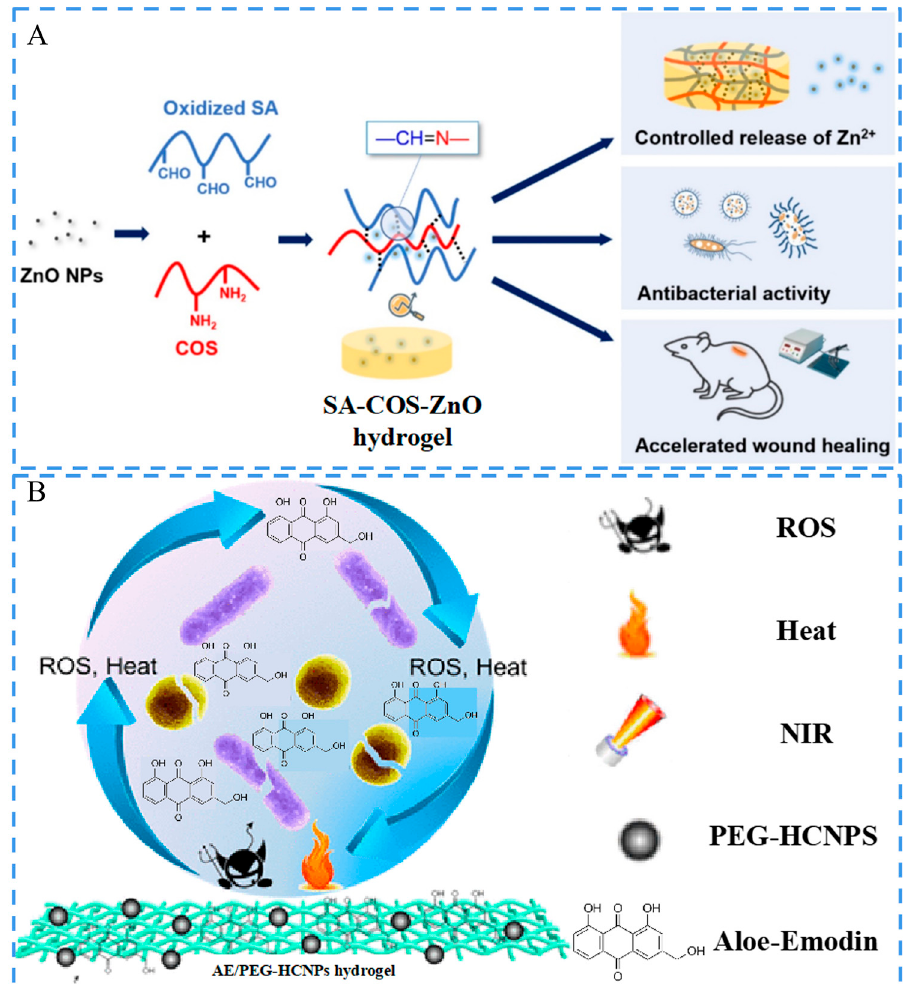
Figure 5. Schematics of the antimicrobial hydrogels. ( A ) Schematic of the construction of SA-COS-ZnO hydrogel with controlled release of Zn 2+ , antibacterial activity, and accelerated wound healing. Reproduced with permission [95]. Copyright 2021, Elsevier. ( B ) Schematic of the function of the AE/PEG-HCNPs hydrogel. The hydrogel exhibited a photothermal effect with ROS scavenging ability. The AE showed antimicrobial activity against G+ and G- bacterial. Reproduced with permission [102]. Copyright 2018, The American Chemical Society.